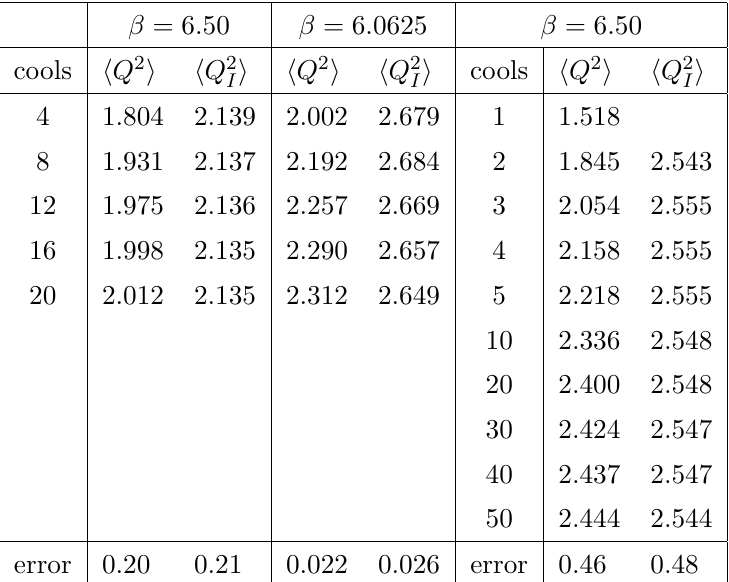
Table 20 . Topological susceptibility versus number of cooling sweeps, using the lattice Q and the integer-valued projection, Q I . For two values of β with a separate calculation at β = 6 . 50 for a wider range of cooling sweeps. The statistical errors are highly correlated between cooling